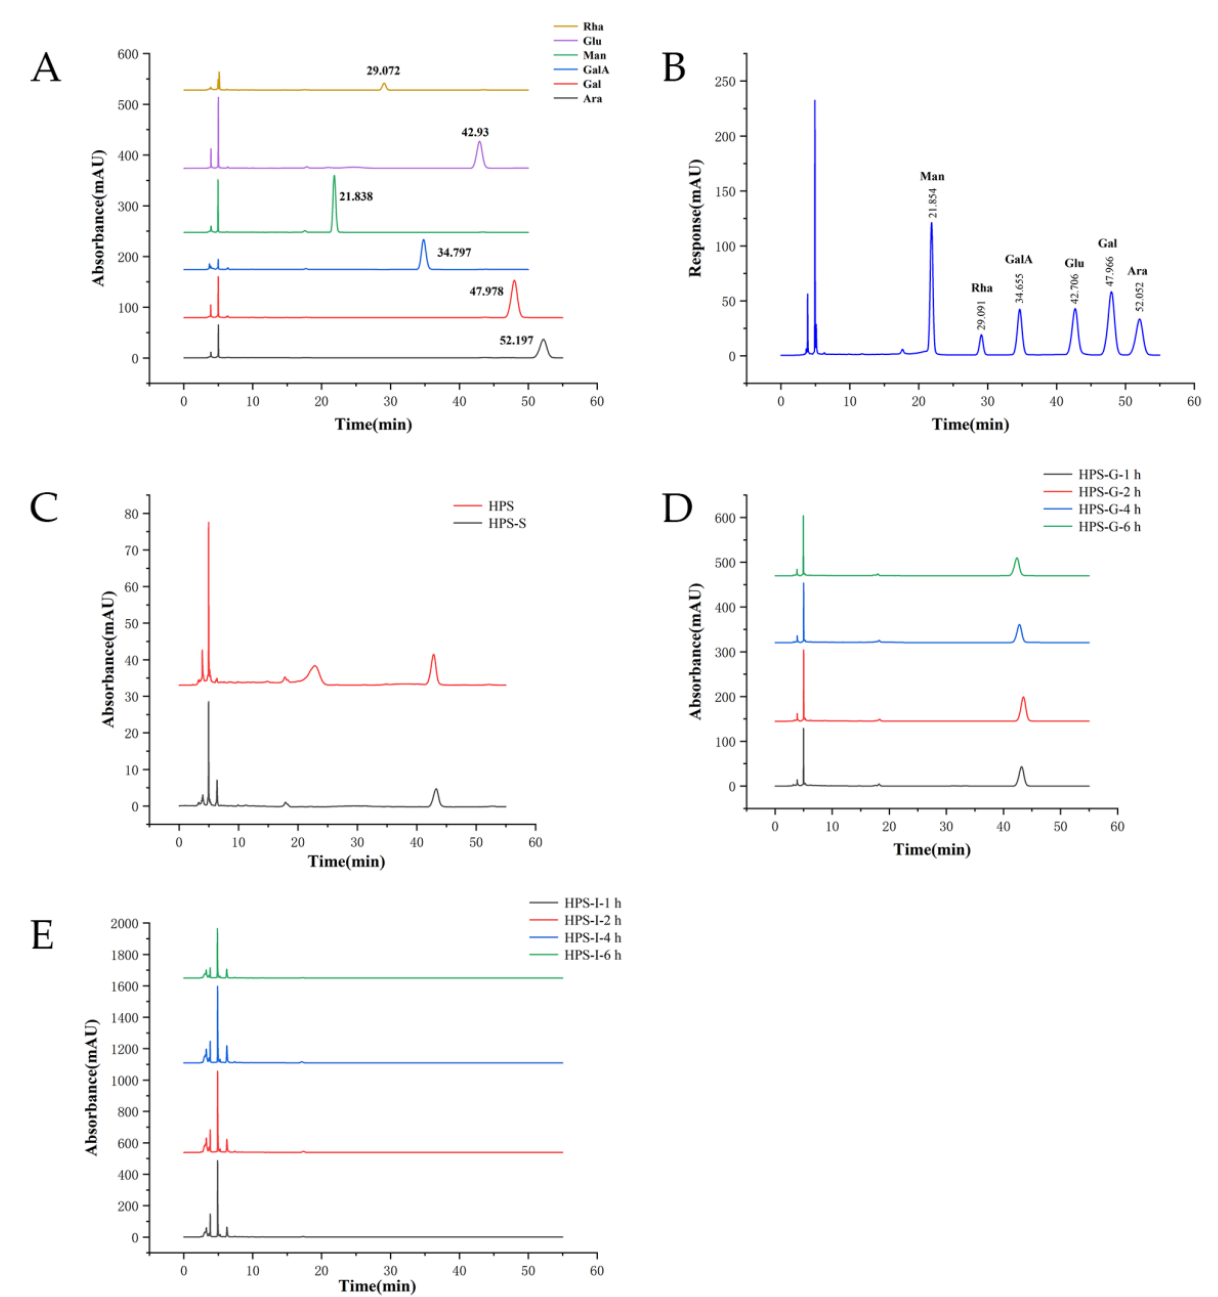
Figure 1. Peak time of six monosaccharides ( A ); HPLC chromatogram of monosaccharide mixture ( B ); changes in free monosaccharides released from HPS during digestion. HPS, hawthorn polysac- charides; HPS-S, salivary digestion of HPS for 0.05 h ( C ); HPS-G-1 h, HPS-G-2 h, HPS-G-4 h, and HPS-G-6 h ( D ), saliva–gastric digestion of HPS for 1, 2, 4, and 6 h, respectively; HPS-I-1 h, HPS-I-2 h, HPS-I-4 h, and HPS-I-6 h ( E ), saliva–gastrointestinal digestion of HPS for 1, 2, 4, and 6 h, respectively.